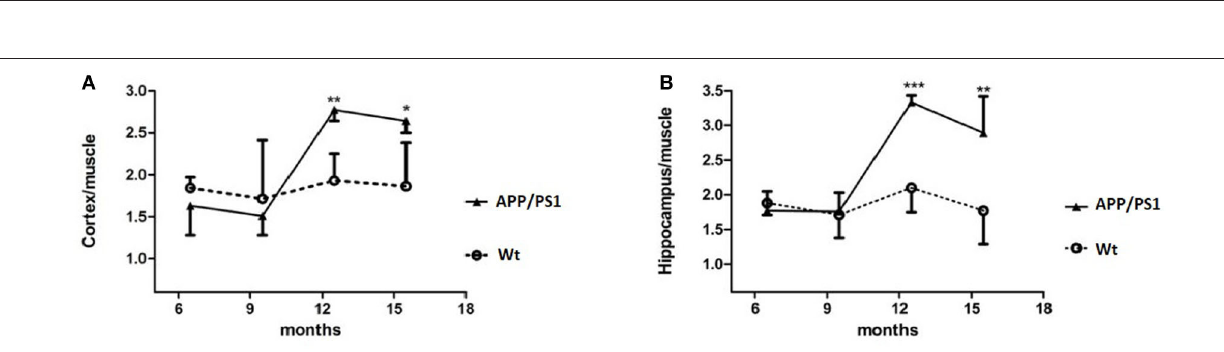
FIGURE 6 | %ID/g to muscle of [ 18 F]DPA714 accumulation in the cortex and hippocampus, at 6–7, 9–10, 12–13, and 15–16 months of age. ∗ p < 0.05, ∗∗ p < 0.01, and ∗∗∗ p < 0.001 compared with Wt age-matched mice ( T